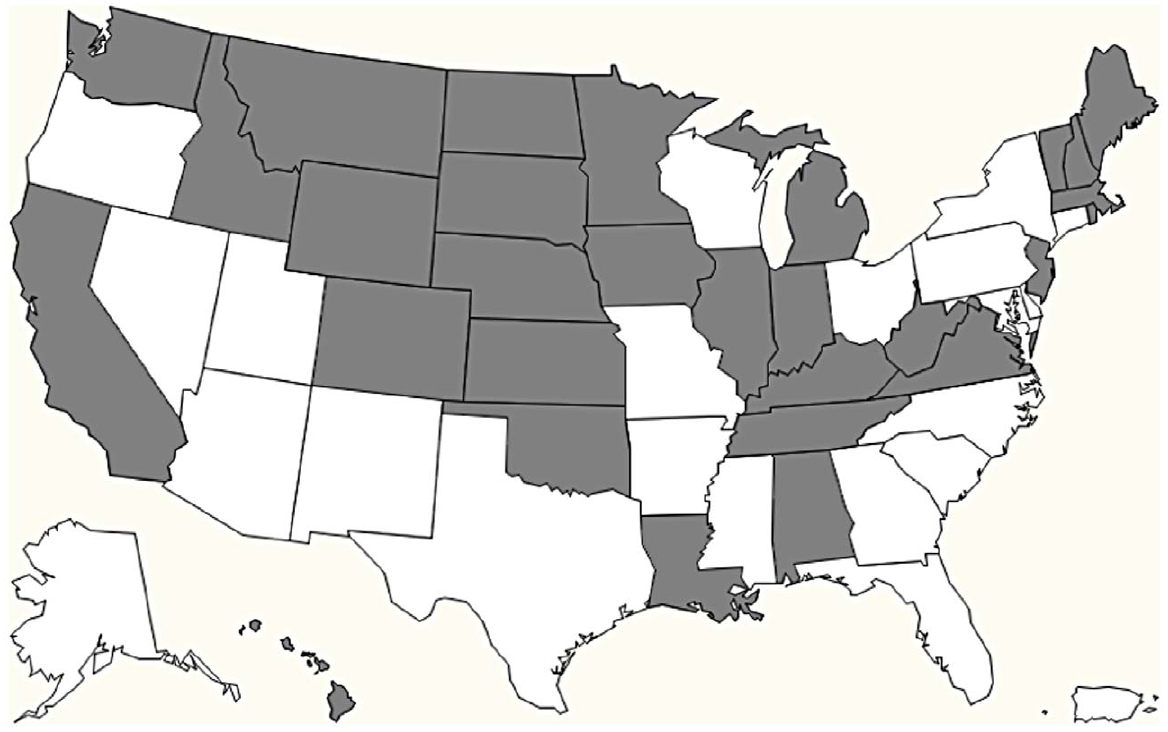
Figure 1. States with poison centers contributing data to study (in gray), 2006–2007. Study sites included 29 states with rural and large metropolitan areas that contributed data to the RADARS System for this analysis. These states included 49.7% of the total US population based on the 2000 Census.